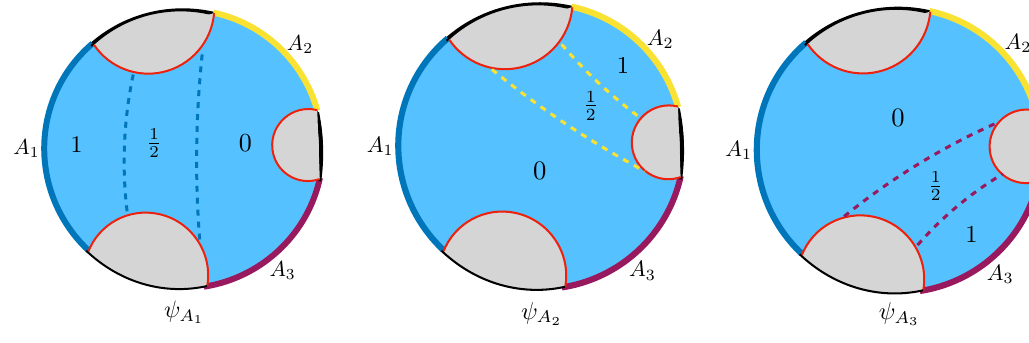
Figure 24 . The corresponding con(cid:12)guration of